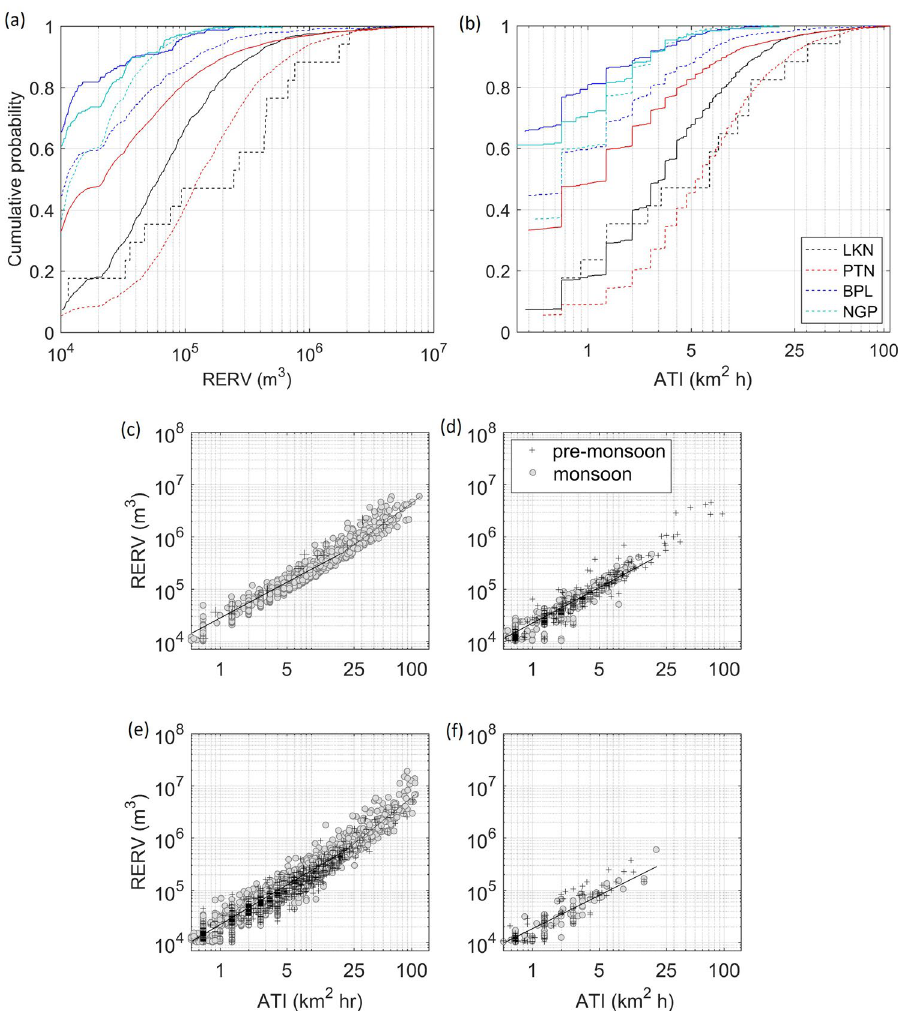
Figure 5. Cumulative probability distributions of ( a ) radar estimated rain volume (RERV) and ( b ) area-time integral (ATI). The dashed and solid curves indicate the pre-monsoon and monsoon season respectively. RERV versus ATI at ( c ) Lucknow, ( d ) Patna, ( e ) Bhopal, and ( f ) Nagpur. Straight lines show best-fit lines to scatter of RERV and ATI at the log–log scale. The solid and dashed best-fit lines correspond to ATI ≤ 20 km > 20 km 2 h, respectively. The data corresponding to pre-monsoon and monsoon seasons are shown by symbols ‘+’ and ‘o’ respectively.